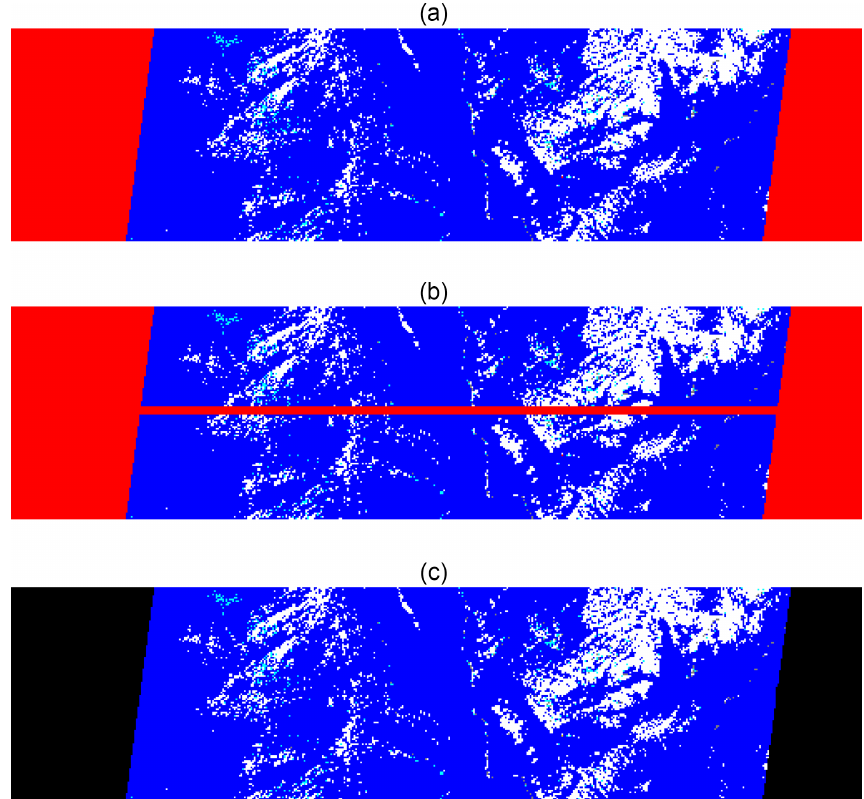
Figure 14. Maps of the RCCM for Path 168, Orbit 92981, Block 101 and camera AF. Linear dimensions are as described in the caption of Fig. 3, while color coding is identical to that indicated in Fig. 9. (a) Map of the original RCCM product, which does not contain missing data; (b) map of the artificially modified RCCM product, where lines 60 to 64 were declared missing; (c) map of the updated RCCM product, where the inserted missing data have been replaced by estimates.